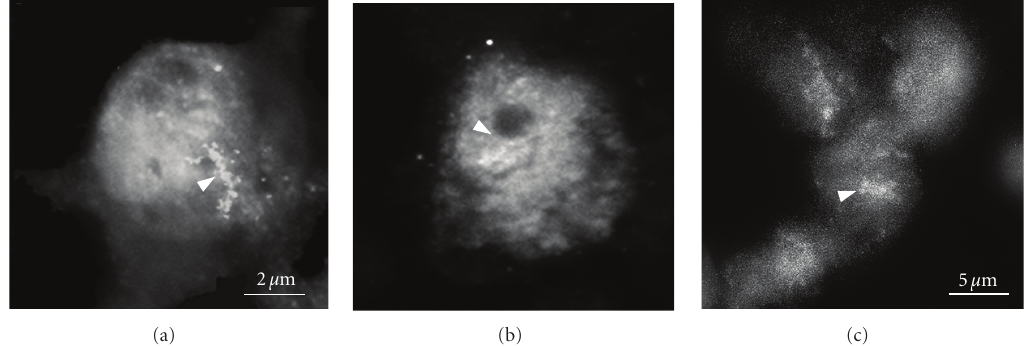
Figure 3: RER binding detected on chick, human and mouse neuronal cells . Specific binding of the biotinylated RER (arrows) to chick (a), human (b) and mouse neuronal (c) cell. Location of the chick neuronal cells is in the IMMP area; Human and mouse neuronal cells are located in the CA1 are in